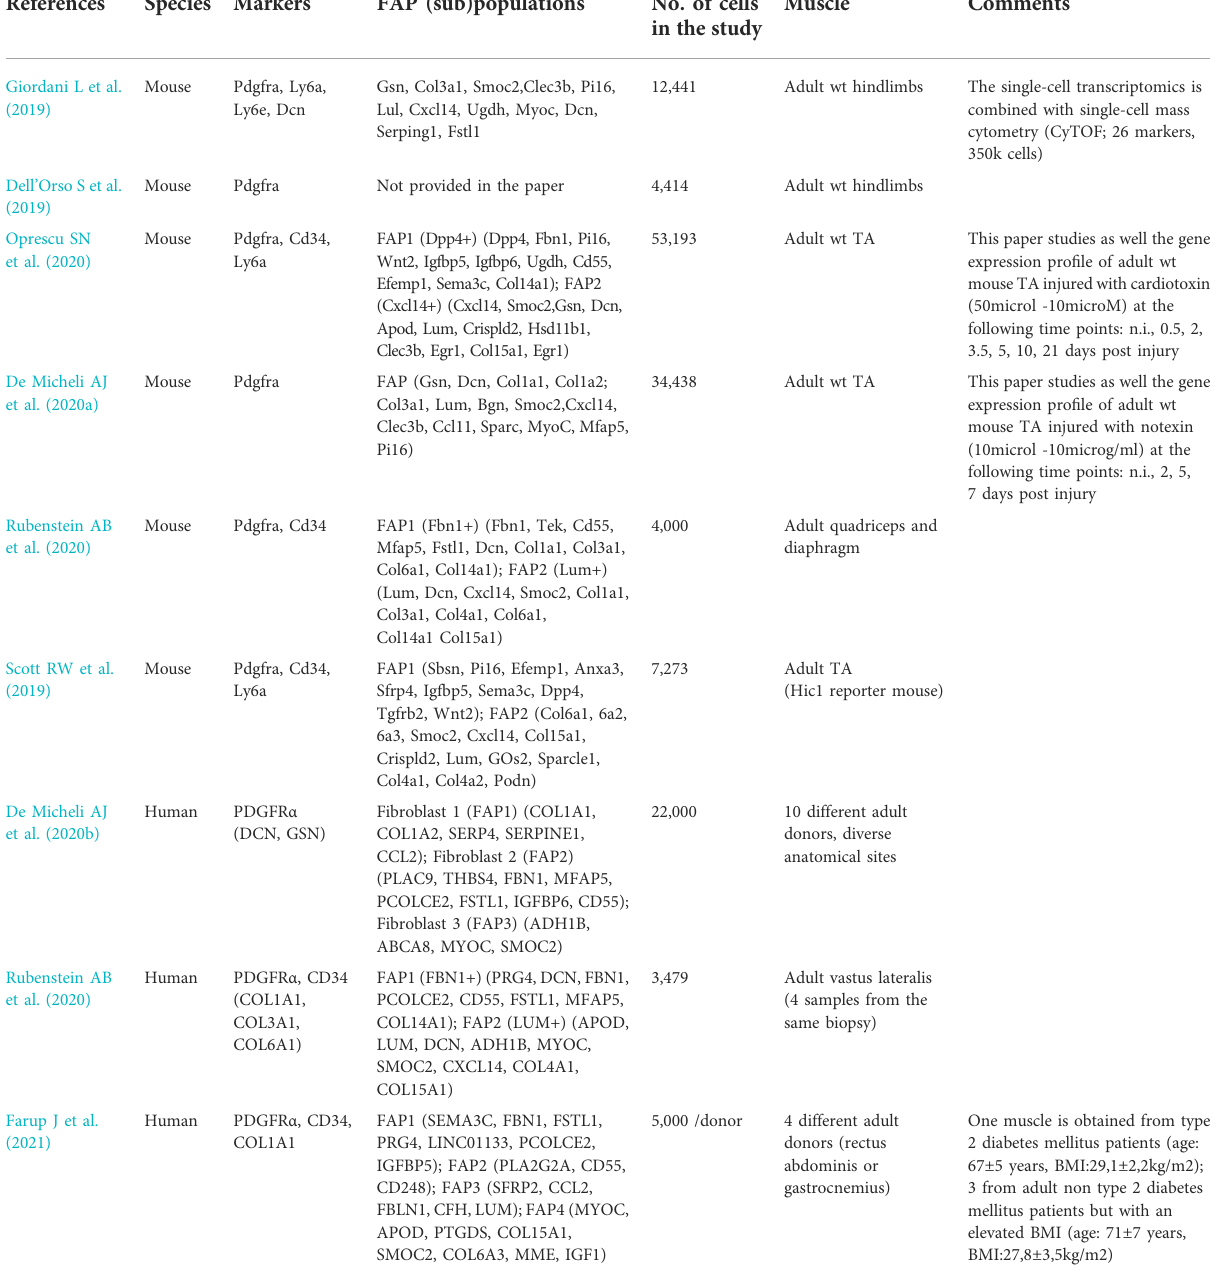
TABLE 1 Sc-RNA-seq unbiased studies showing FAP populations in muscle